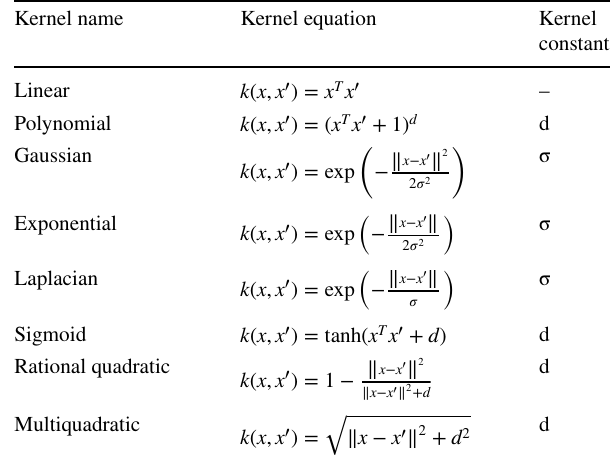
Table 1 Used kernel function